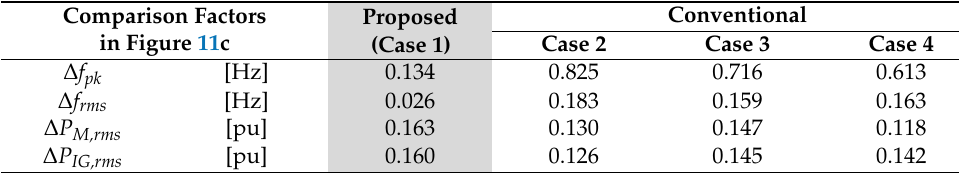
Table 8. Comparisons for the continuous load variations.